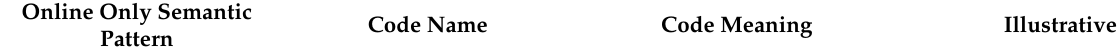
Table A3. Semantic Patterns in SP data online only.